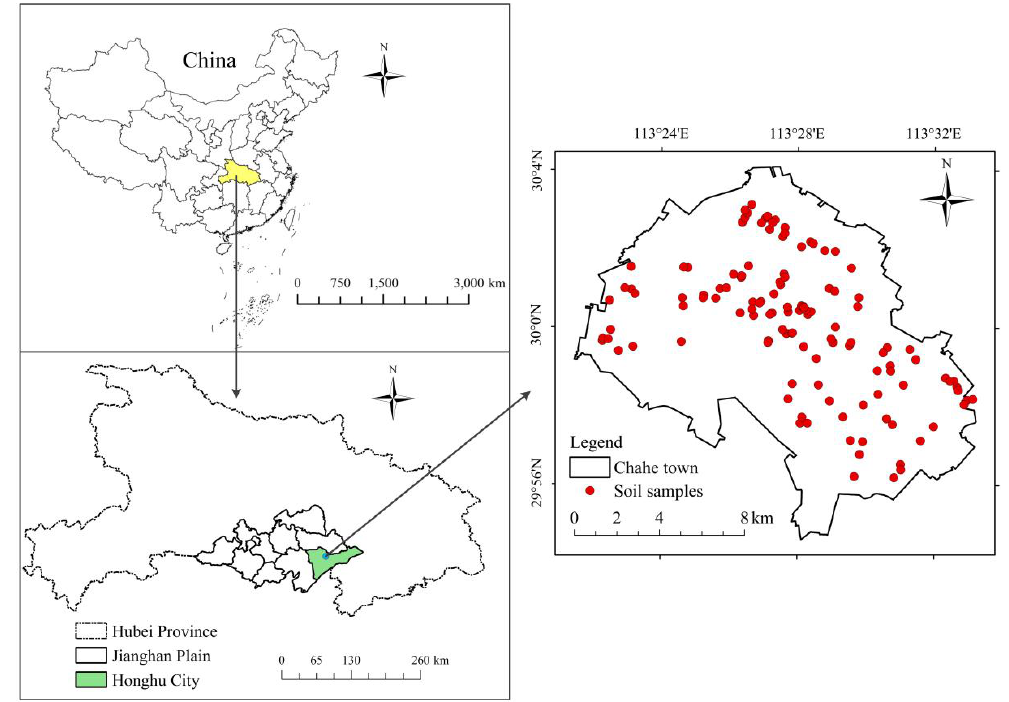
Figure 1. Study area and the location of each sampling site.